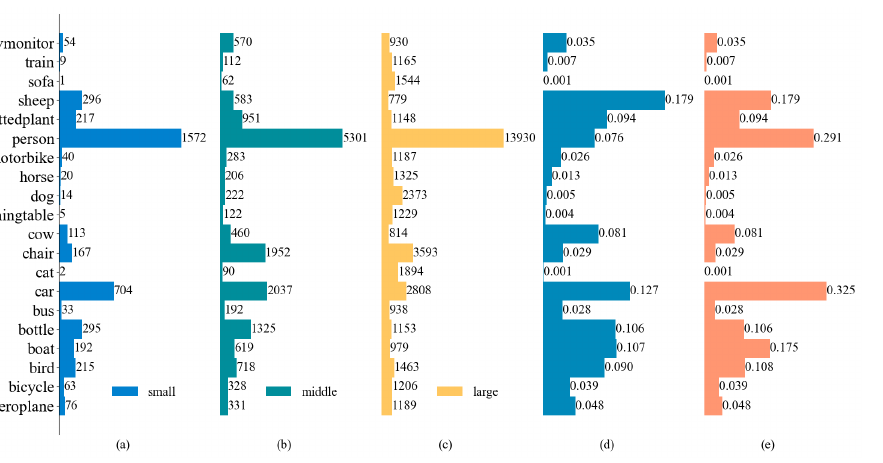
Figure 10. The distribution of the sample labels for VOC07+12. The number of small, medium, and large object labels in VOC datasets for each category are displayed in ( a – c ). The percentage of small object labels in each category is displayed in ( d ). The percentage of small object labels in training datasets is displayed in ( e